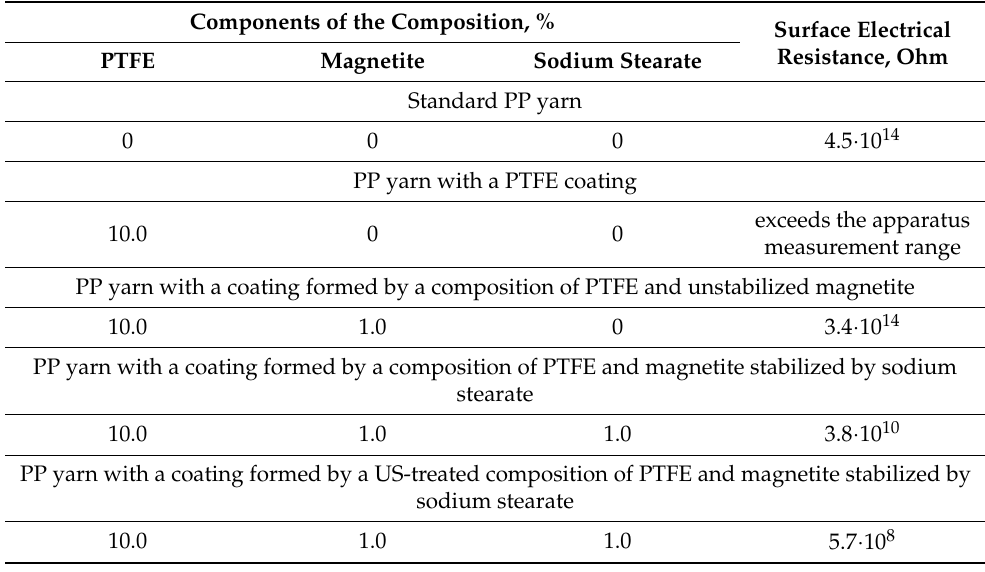
Table 2. Surface electrical resistance of PP yarns with a PTFE coating doped with magnetite particles. Components of the Composition, % Surface Electrical Resistance, OhmPTFE Magnetite Sodium Stearate Standard PP yarn 0 0 0 PP yarn with a PTFE coating exceeds the apparatus 10.0 0 measurement range PP yarn with a coating formed by a composition of PTFE and unstabilized magnetite 10.0